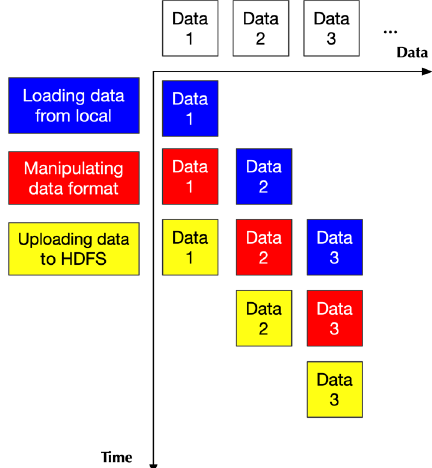
Figure 4. The pipeline structure in the pre-processing stage (hardware perspective). At the first time-unit, loading data hardware would process the first set of data. At the next time-unit, loading data hardware would process the next set of data, while manipulating data format hardware would start to process the first set of data. This process continues until uploading data hardware finishes the processing of the last data set.